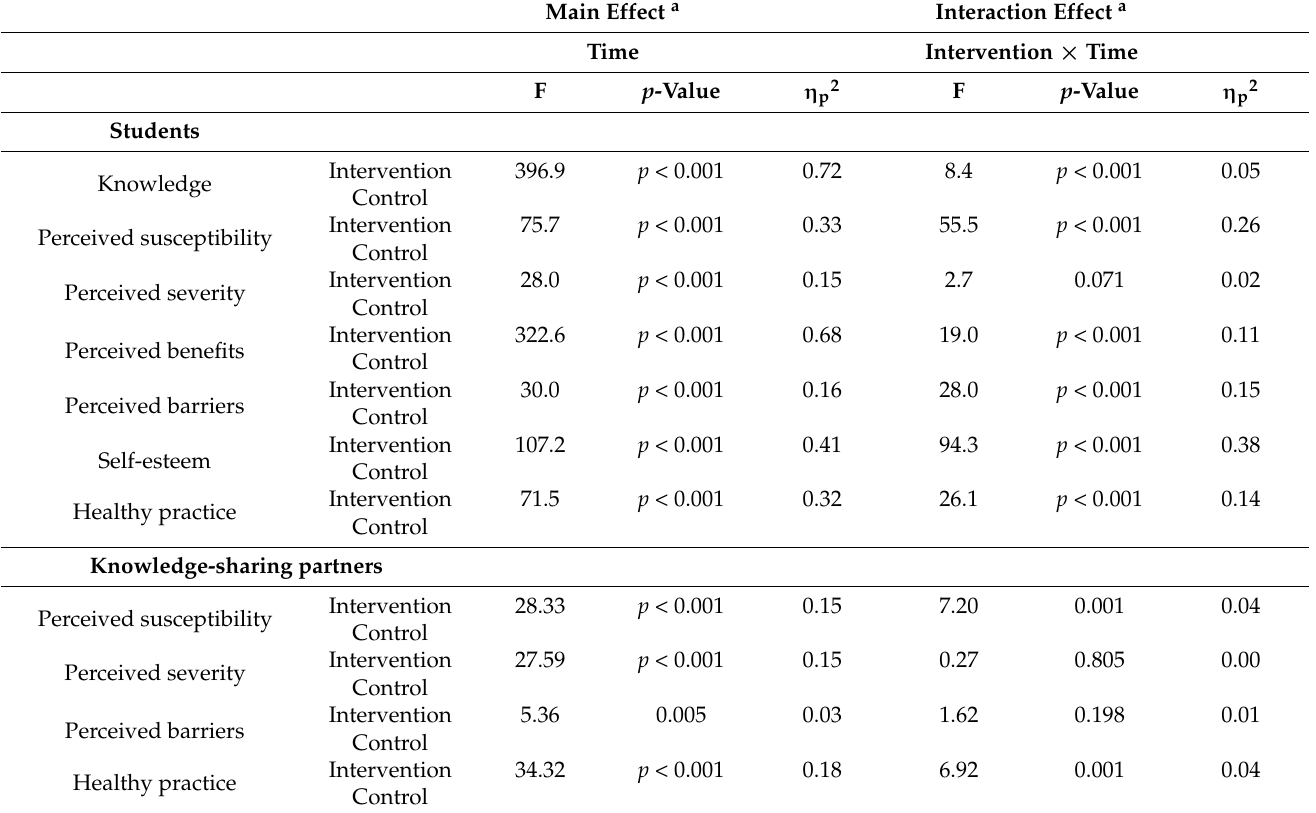
Table 2. Effect on Variables of Students’ and Knowledge-sharing partners groups at Repeated Time